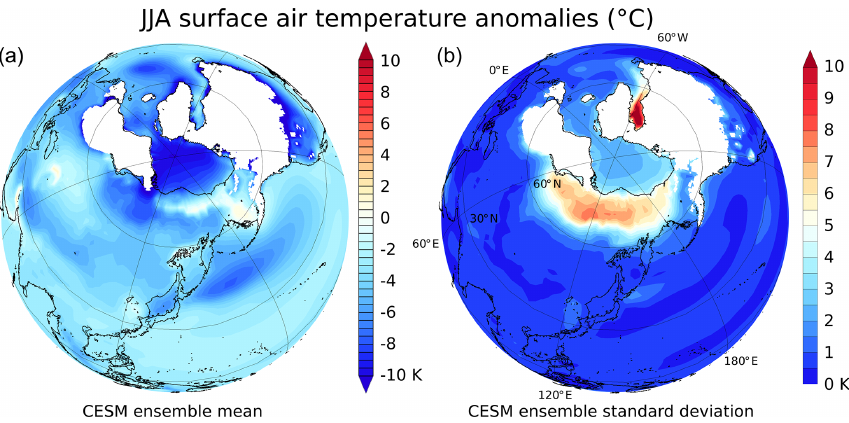
Figure 4. CESM ensemble mean (a) and ensemble standard deviation (b) of LGM JJA temperature anomalies ( ◦ C). Note that regions covered by continental ice sheets during the LGM have been masked out. The LGM coastlines are given in